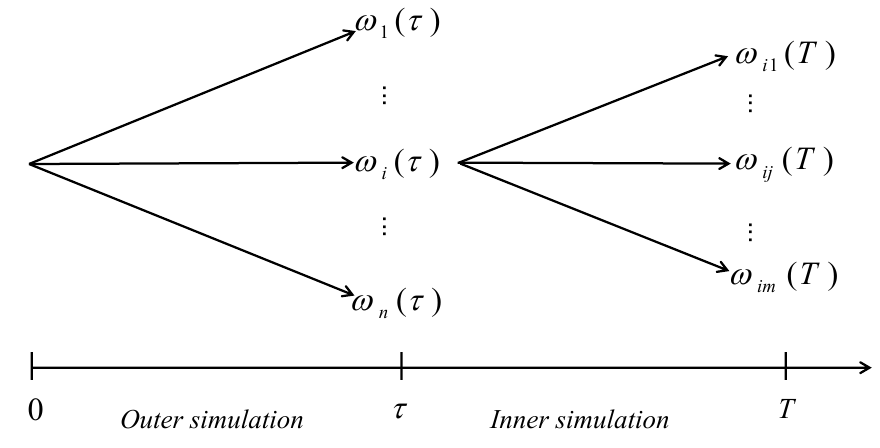
Figure 1. Nested